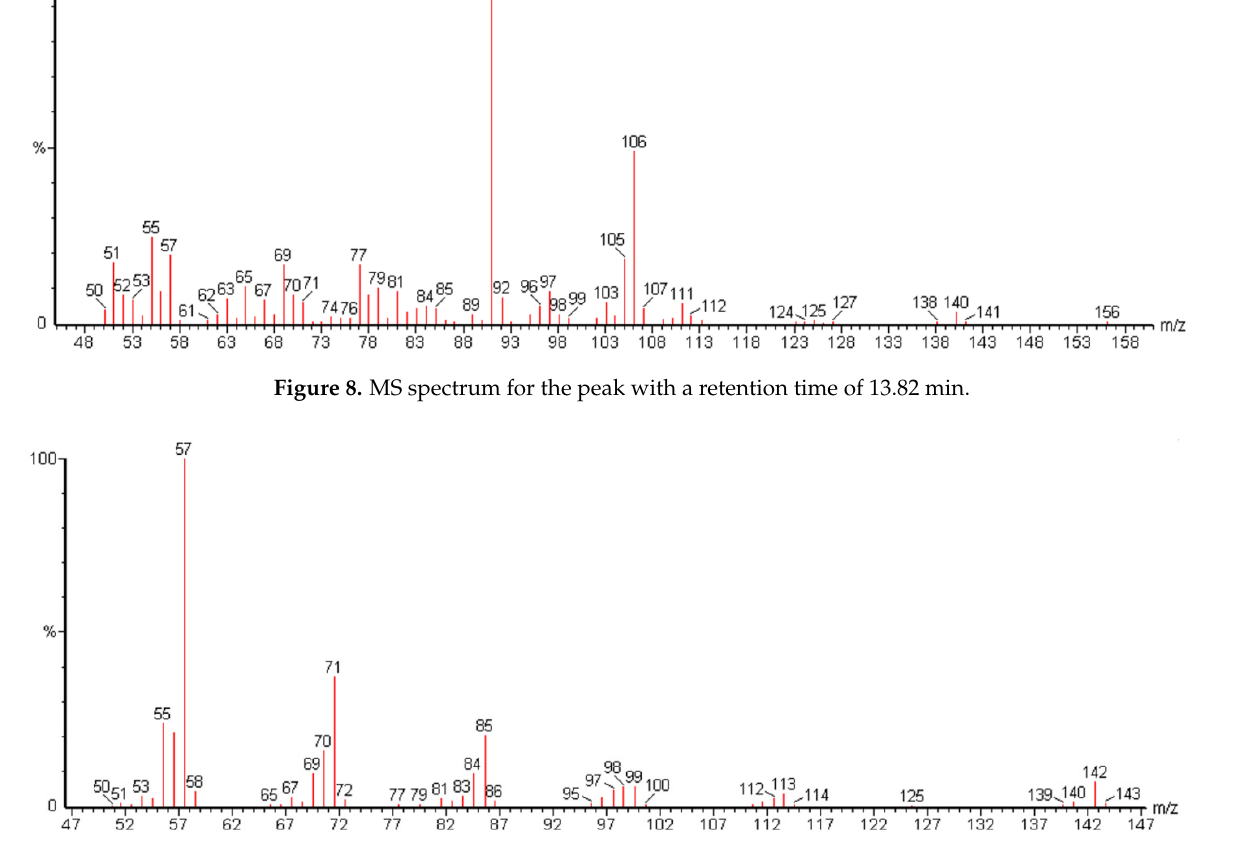
Figure 9. MS spectrum for the peak with a retention time of 13.61 min.